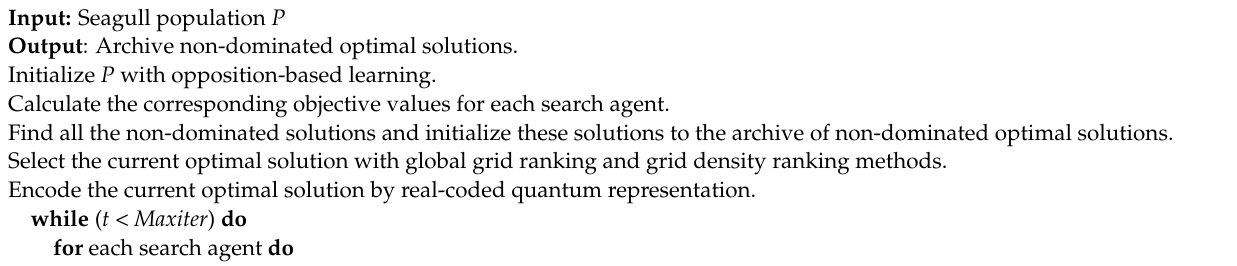
Algorithm 1 Multi-Objective Quantum-Inspired Seagull Optimization Algorithm